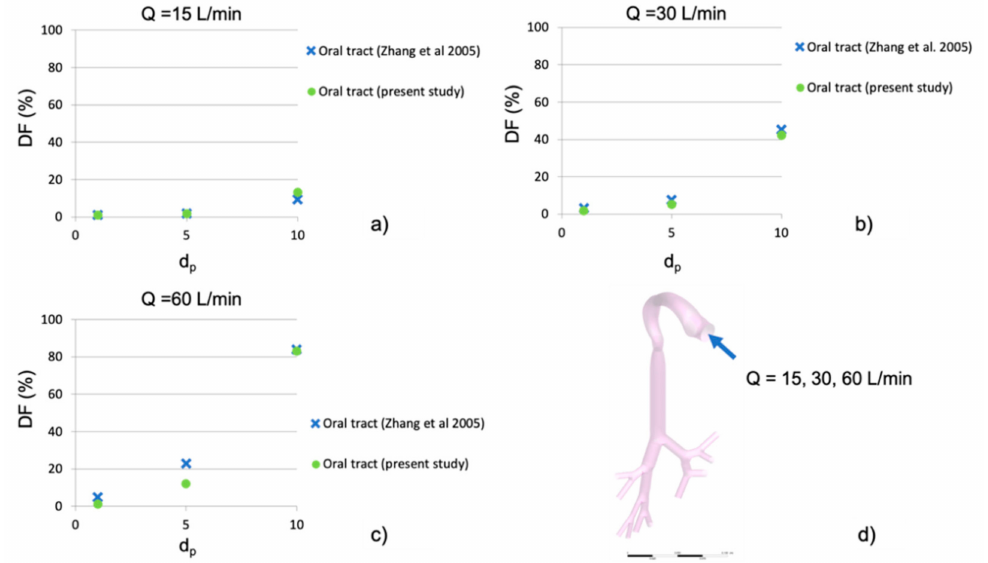
Figure A1. Computational human model used for validation: deposition fractions (DF; in %) are computed and displayed as a function of the particle diameter d p (in µ m). Inspiratory flows Q of 15, 30, and 60 L/min are used for simulating light, normal, and heavy activities. Comparison between literature and the human idealized computational model of the aerosol deposition fractions as a function of the particle diameter at ( a ) Q = 15 L/min, ( b ) Q = 30 L/min and ( c ) Q = 60 L/min. In ( d ), the geometrical model used for the simulations is shown with the different breathing rates Q (blue